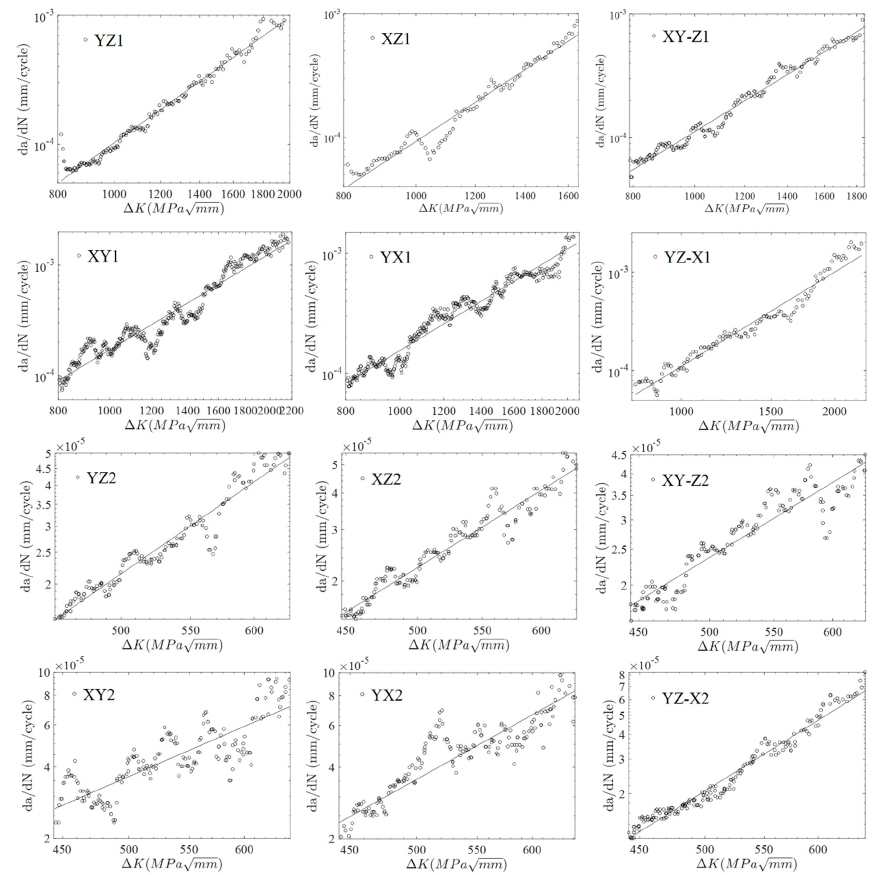
Figure 7. The fitting results of the fatigue crack growth rate. The corresponding code of the specimen is shown in each image.